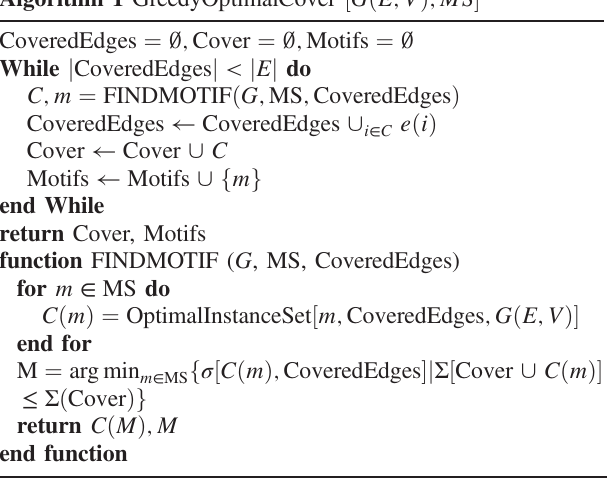
Algorithm 1 GreedyOptimalCover ½ G ð E; V Þ ; MS (cid:2) CoveredEdges ¼ ∅ ; Cover ¼ ∅ ; Motifs ¼ ∅